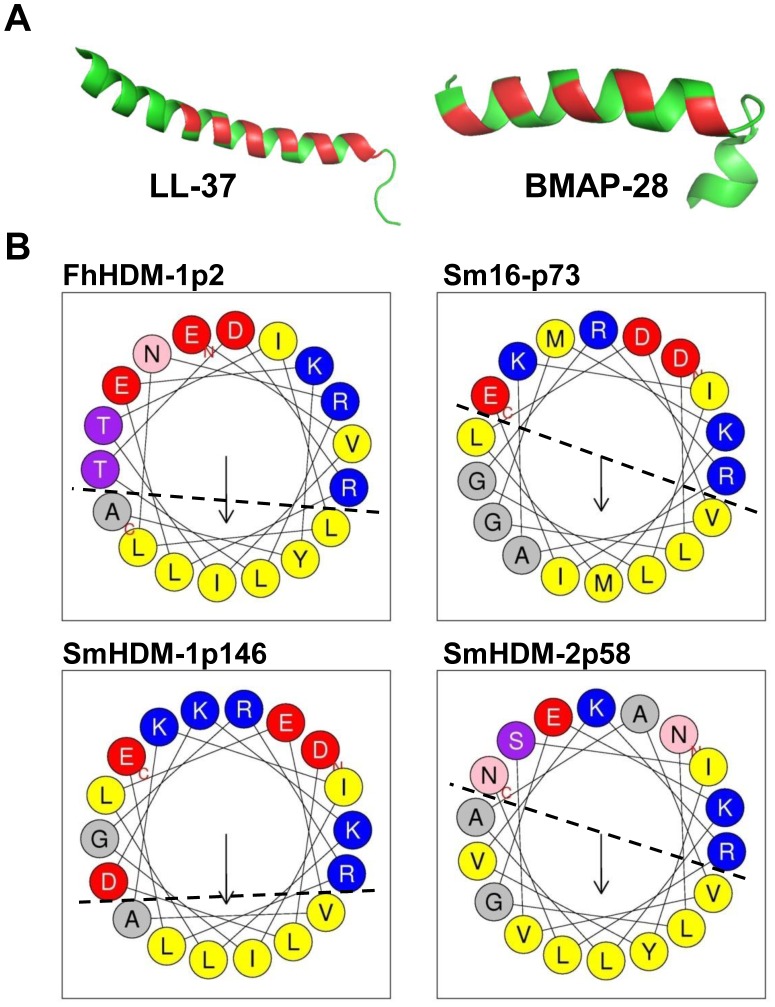
Mammalian and helminth cathelicidin-like peptides share homologous secondary structure.(A) Most HDPs, including those used in the present study, form amphipathic helices. Here, the atomic structures of LL-37 (PDB ID: 2K6O) and BMAP-28 (PDB ID: 2KET) are shown as green ribbon with the residues comprising the hydrophobic face of the molecules coloured red. Structures were generated using Pymol (http://www.pymol.org). (B) Helical wheel analysis shows that peptides derived from FhHDM-1p2 (residues 14–34), Sm16-p73, SmHDM-1p146 and SmHDM-2p58 (residues 9–26 for each) also form distinct amphipathic structures.